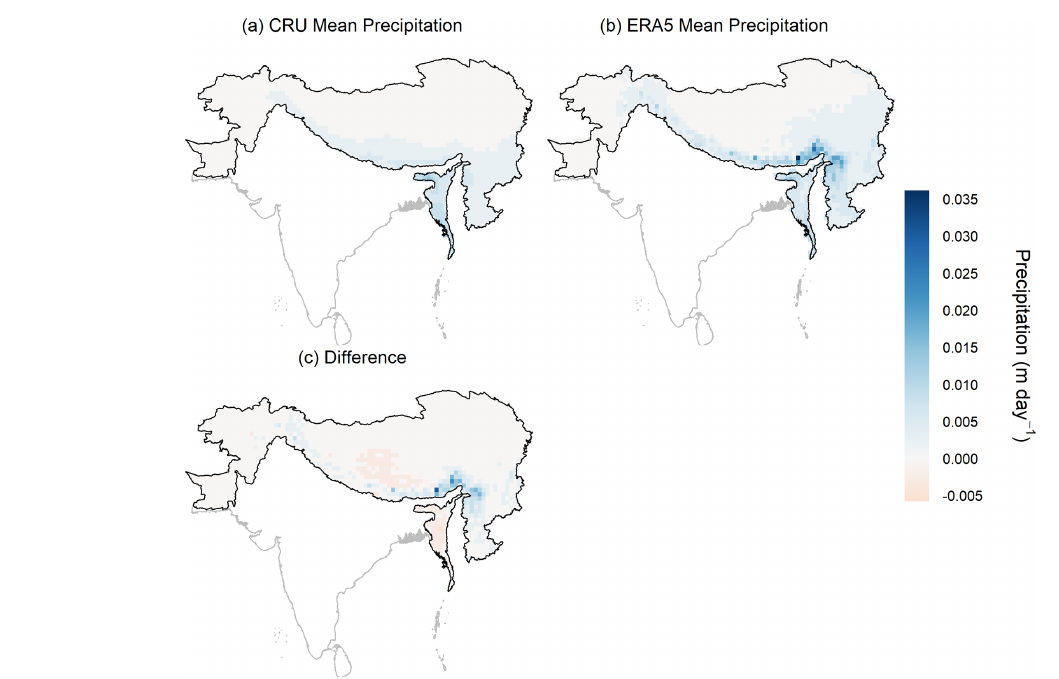
Figure 10. Comparison of precipitation (a) average CRU (1960–1990), (b) ERA5 data (1979–1990) and (c) the difference between the ERA5 and CRU datasets in md − 1